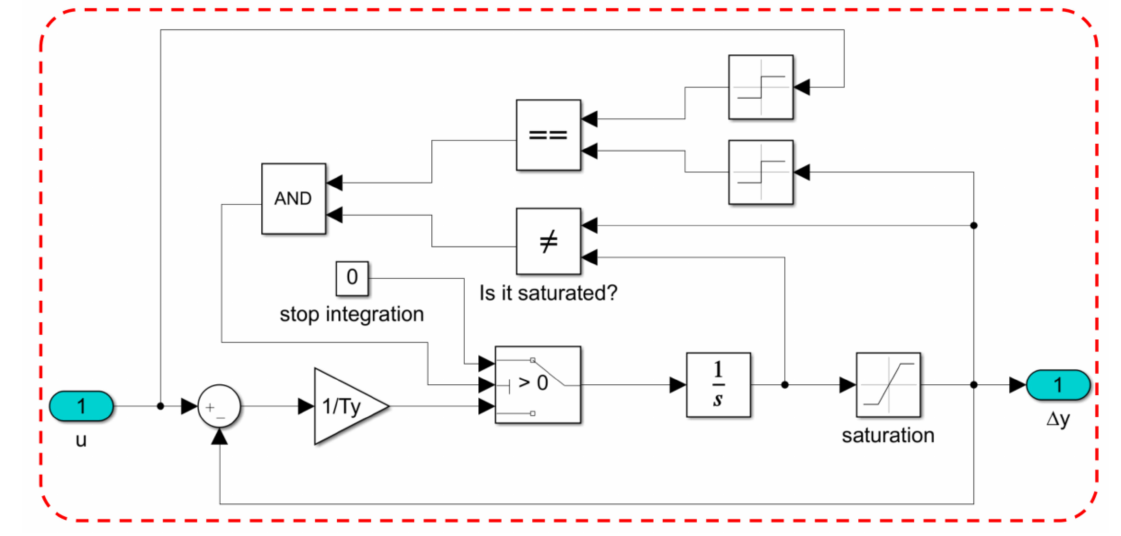
Figure 10. Simulation model of actuator.